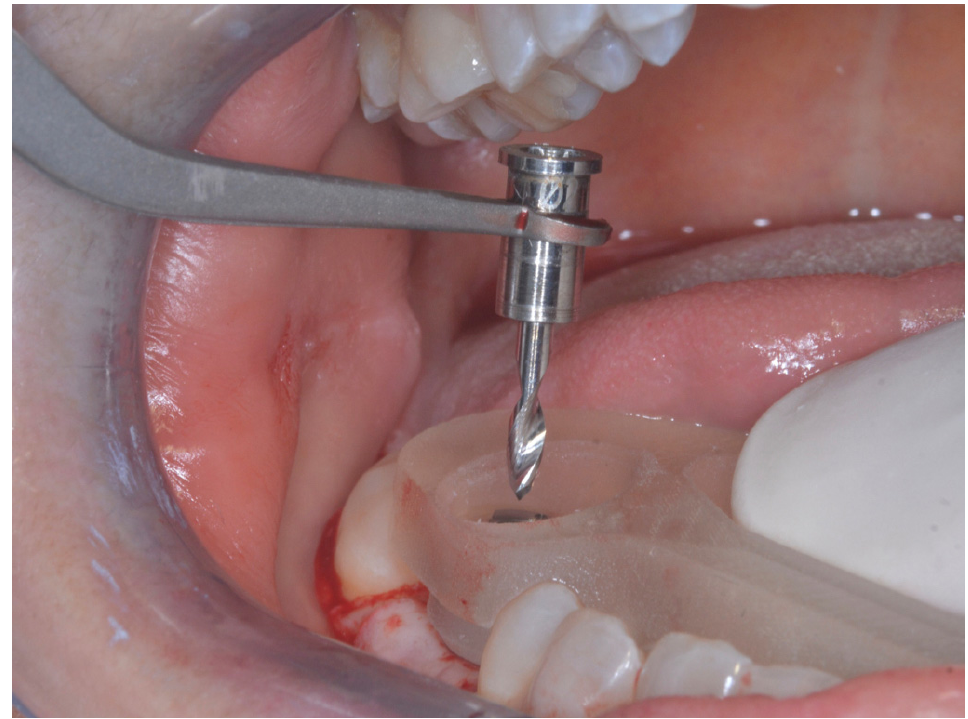
Figure 10. Intraoperative view of the progressive working drills (working depth 7 mm; diameter 2 mm; also available: diameters 2.5, 3, and 3.25 mm).